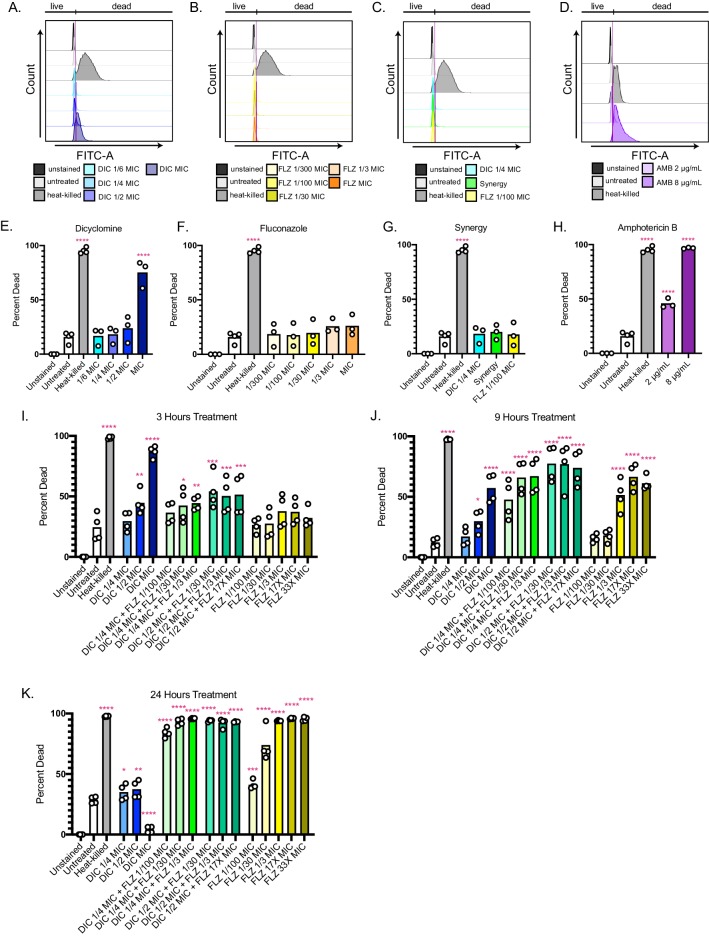
Fungicidal effects of dicyclomine and combination treatment.Representative flow plots for dicyclomine (A) fluconazole (B) synergistic combination (C) and amphotericin B (AMB) (D) showing the gates for live and dead cells. Quantification of percent of dead cells for dicyclomine (E) fluconazole (F) synergistic combination (G) and amphotericin B (H). **** represent p<0.0001 compared to untreated (uncorrected Fisher’s LSD). Quantification of percent of dead cells after treatment for 3 hr (I) 9 hr (J) and 24 hr (K). * represents p=0.02, ** represents p=0.008, *** represent p>0.001 and<0.001 , **** represents p<0.0001 compared to untreated (uncorrected Fisher’s LSD). Heat-killed cells were plated out for survival (Figure 6—source data 2).